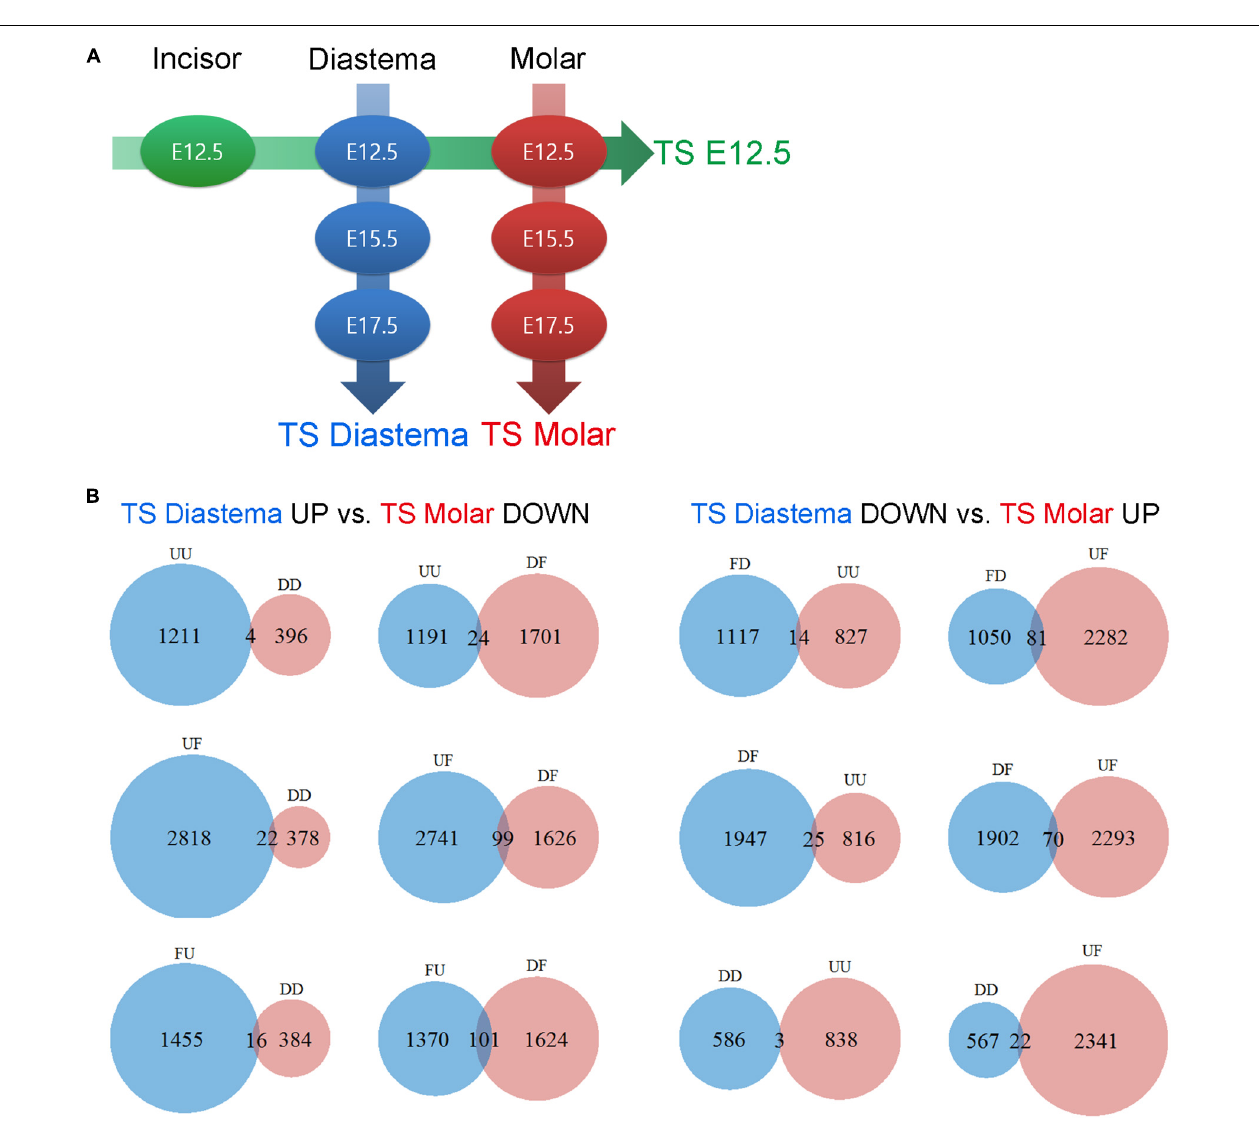
FIGURE 4 | Time series analysis. Time series analysis of time- or region-dependent changes in gene expression patterns. (A) Three time series axes were generated from seven experimental groups: TS E12.5, TS Diastema, and TS Molar. (B) Gene counts of TS Diastema and TS Molar move in opposite direction in a time-dependent manner. The gene expression patterns between the elements on an axis are labeled as Up (U), Flat (F), or Down (D). UU or DD, genes gradually increased or decreased during development; UF or DF, genes increased or decreased between E12.5 and E15.5, then remained flat between E15.5 and E17.5; FU or FD, genes remained flat between E12.5 and E15.5, and then changed between E15.5 and E17.5.